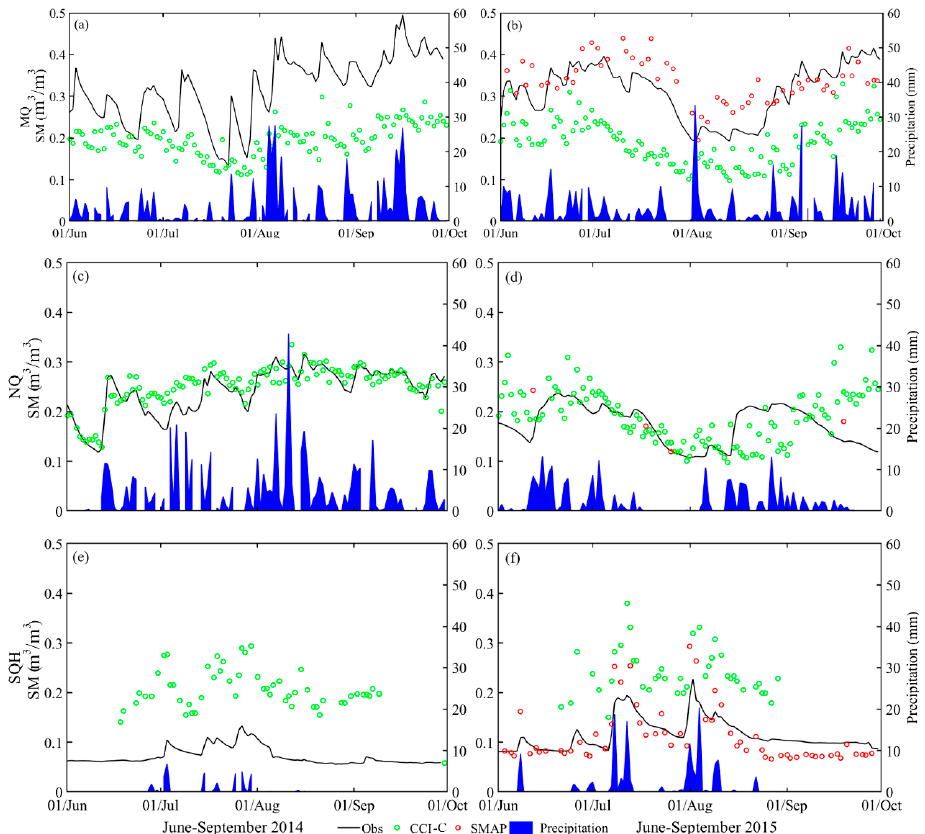
Figure 3. SMC time series from two satellite-based CCI-C and SMAP products and in-situ observations in the MQ ( a , b ), NQ ( c , d ), and SQH ( e , f ) areas from June–September in 2014 and 2015, respectively.